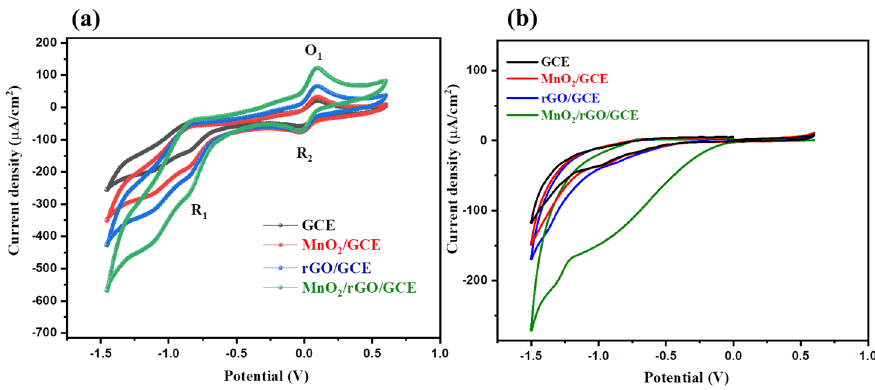
Figure 4. CV of GCE, MnO 2 /GCE, rGO/GCE and MnO 2 /rGO/GCE in the presence ( a ) and absence ( b ) of 50 µM 4-NP (scan rate = 50 mV/s).